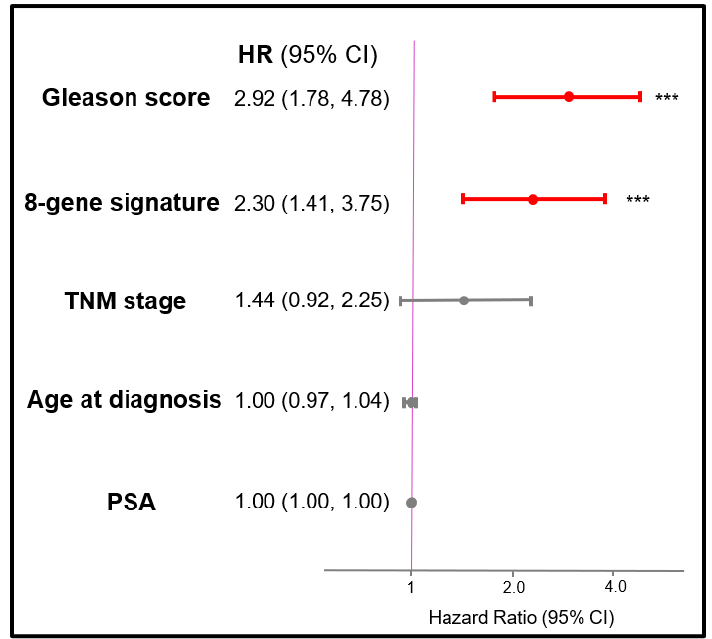
Figure 3. Multivariate analysis for progression-free interval. Multivariate Cox regression of the 8-gene signature with clinical variables. Significance levels are annotated. Clinical factors such as gleason score, psa level, tumor TNM stage, and age at diagnosis were considered as confounding variables in the analysis. Both hazard ratios and 95% confidence intervals were shown in the forest plot and factors reached a significant level were plotted in red. *** p -value < 0.001.